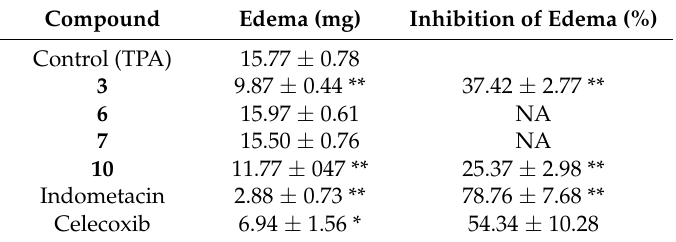
Table 8. Inhibitory effect of compounds 3 , 6 , 7 and 10 on TPA-induced inflammation in a mouse model. Compound Edema